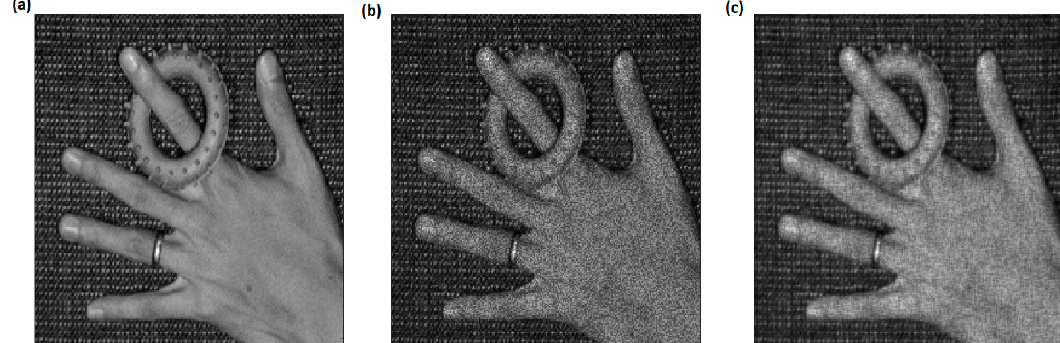
Figure 18. ( a ) Original image, ( b ) Image with the addition of Gaussian white noise (Input PSNR = 19.27 dB), ( c ) Denoising with proposed method (Output PSNR = 26.42